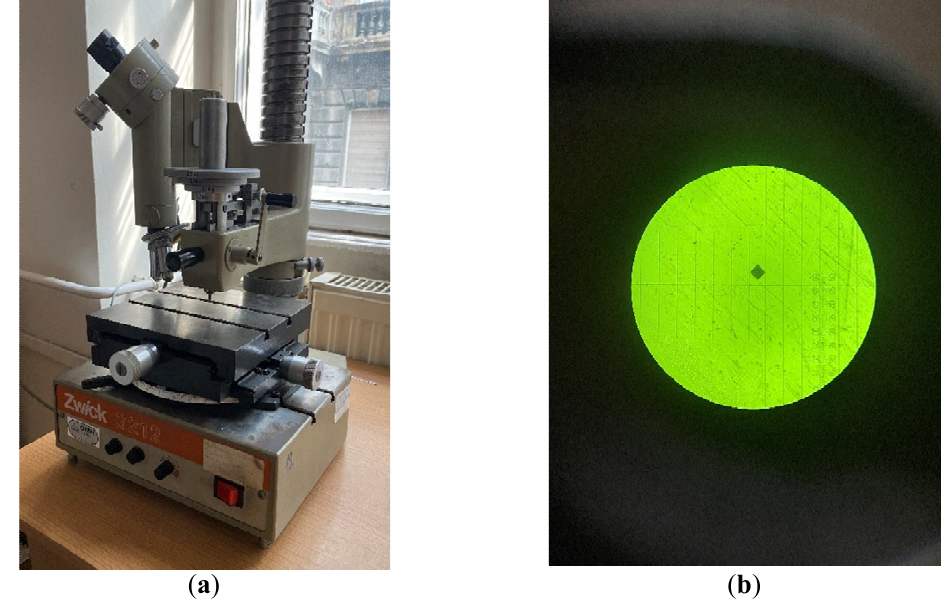
Figure 2. Hardness tester ( a ) front view ( b ) indented trace measurement.